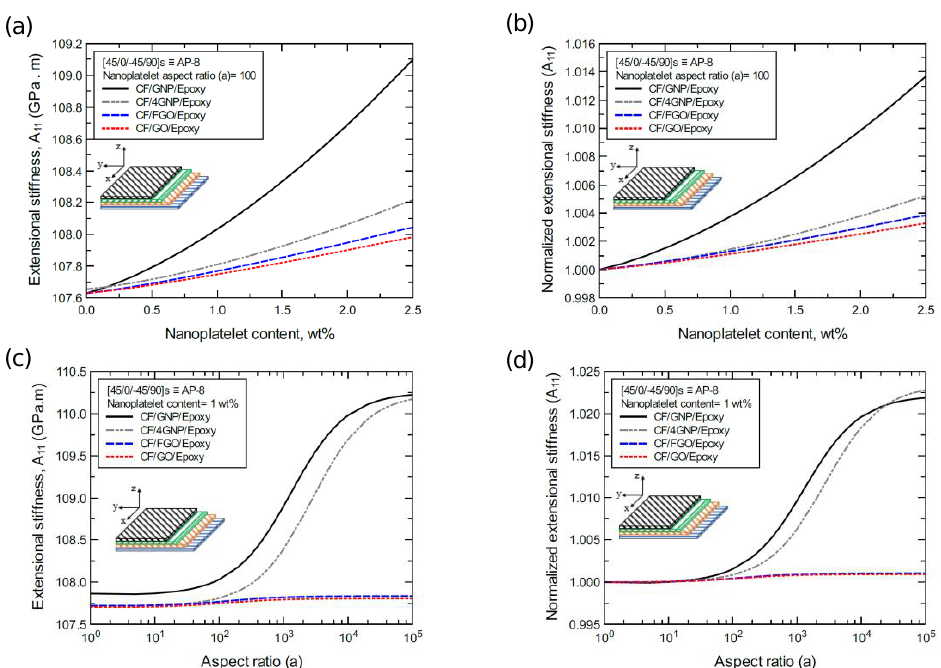
Figure 13. Comparison of the predicted extensional stiffness (A 11 ) for a [45/0/-45/90]s (AP-8)-laminated composite plate based on the nanoplatelet type, content, and aspect ratio; ( a ) predicted A 11 for various nanoplatelet contents at 100 aspect ratio, and the normalized response is shown in ( b ); ( c ) predicted A 11 for various aspect ratio values at 1.0 wt% nanoplatelet content, and the normalized response is shown in ( d ). The volume fraction of CF is 56%.